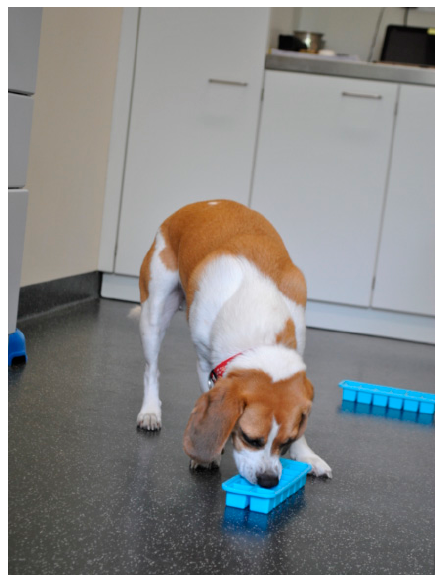
Figure 8. ‘Happy Visits’ enable positive experiences in the clinic environment. In this setup, several forms filled with lickable food (normal wet food works well) are spread throughout the examination room and the dog is free to choose without any pressure. A reduced version of such a ‘happy visit’ can also be offered during normal consultations—the dog can lick some food while the veterinarian is taking the history. Photo: Stefanie Riemer.